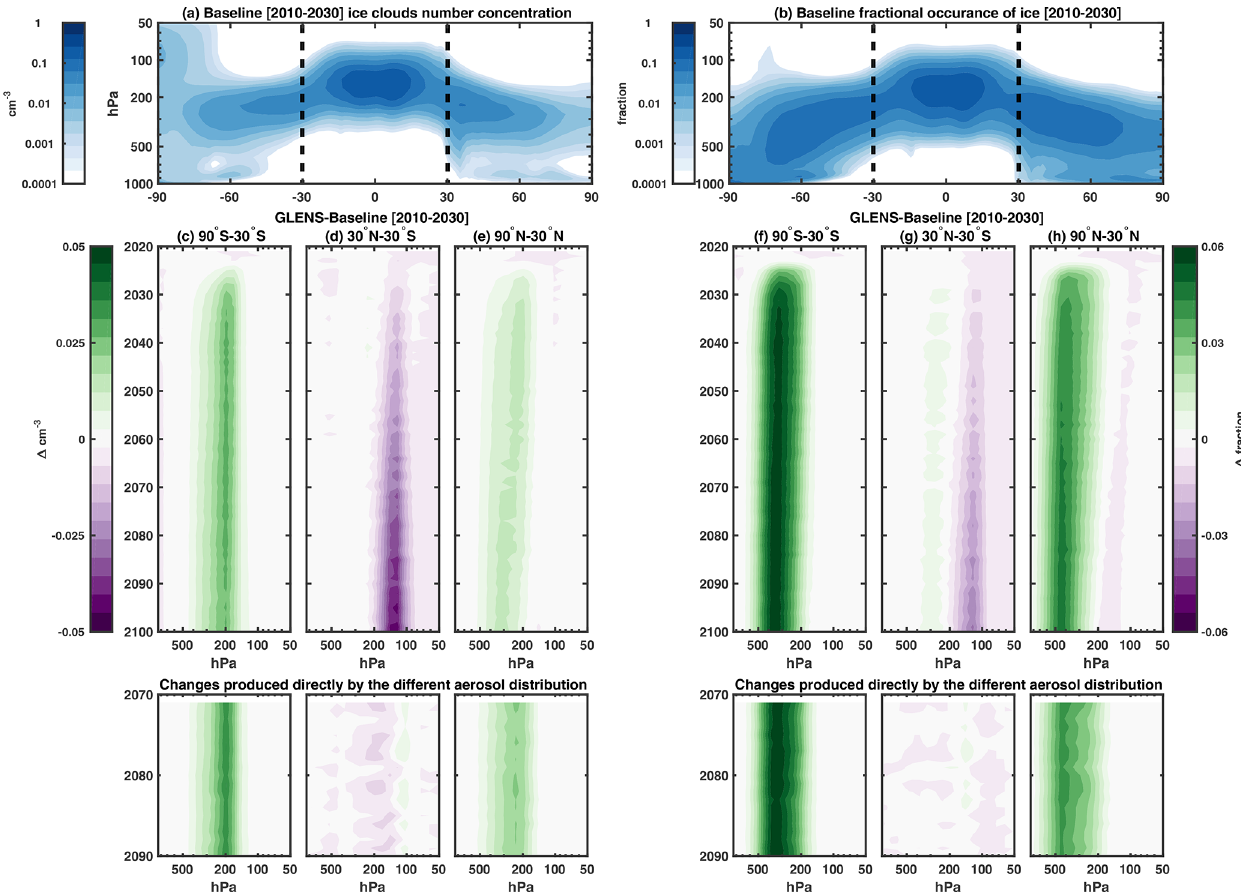
Figure 5. Baseline concentration of cloud ice number concentration ( a , number of particles per cm − 3 ) and fractional occurrence (b) for the period 2010–2030. In panels (c) – (e) and (f) – (h) , the yearly evolution of the differences between GLENS and Baseline (in the 2010–2030 period, as for the panels above) are shown for the three latitudinal boxes separately. In the small bottom panels, the effects of the changes produced by the aerosols are isolated by plotting the difference between GLENS and the simulations with surface cooling and stratospheric heating but no